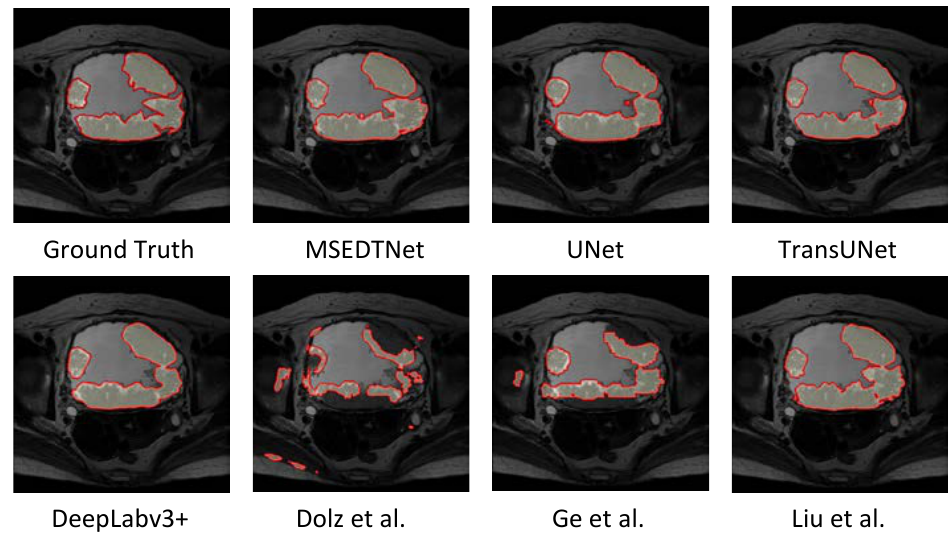
Figure 9. Visual comparison of bladder cancer segmentation results